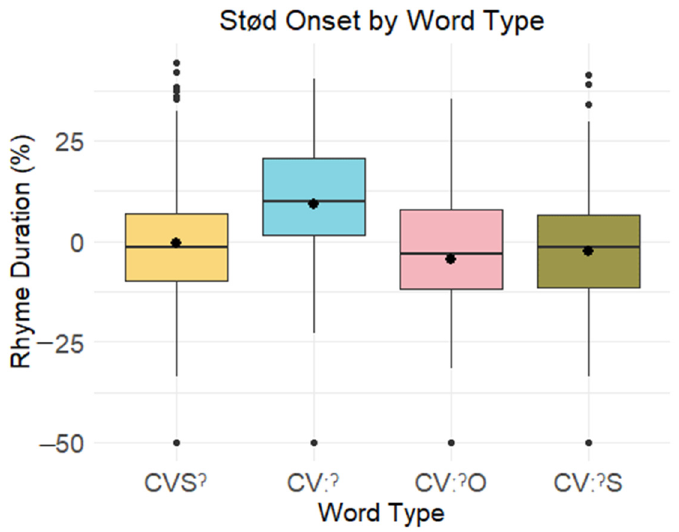
Figure 8. Stød onset (rhyme center measure) by word type, scaled from − 50% to 50%. Negative rhyme durations indicate stød onset times in the first 50% of the rhyme. CV ːˀ O words have early stød onset times and CV ːˀ words have late stød onset times compared to the overall average across word types, which does not differ significantly from 0. Black dots indicate the mean stød onset time per word type.